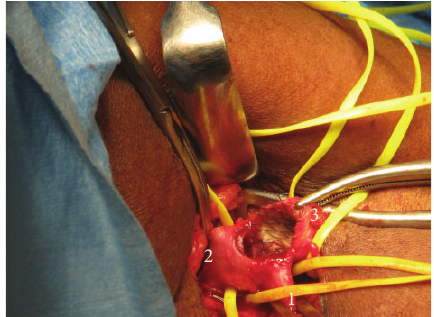
Figure 1: Duplex Doppler ultrasound of the left antecubital fossa demonstrating a significant steal syndrome. Blood enters the proxi- mal brachial artery (1) and > 70% is shunted through the PTFE graft (3) with < 30% flow through the native distal artery (2).